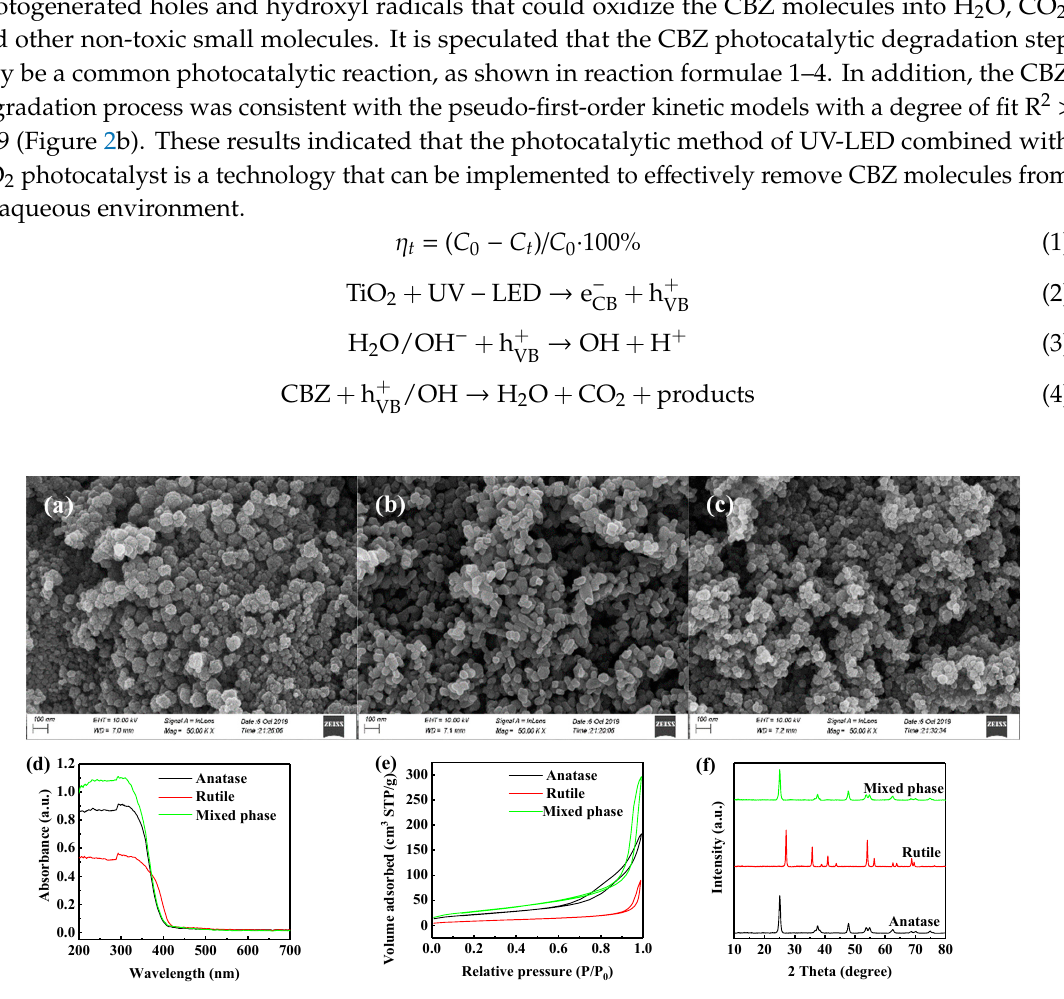
Figure 1. SEM images, UV-Vis graphs, and XRD patterns of anatase, mixed phase, and rutile forms of TiO 2 nanoparticles. ( a–c ) SEM images, ( d ) UV-Vis DRS, ( e ) N 2 adsorption-desorption isotherms, and ( f ) XRD patterns. Catalysts 2020 , 10 , x FOR PEER REVIEW